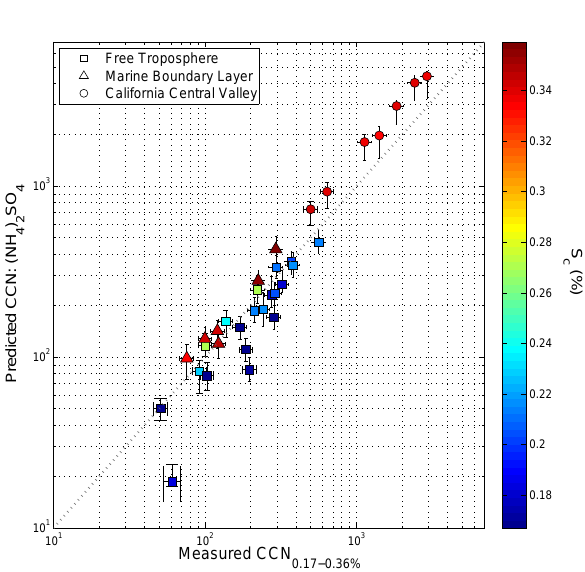
Fig. 4. Predicted CCN vs. measured CCN. Predicted CCN were calculated using pure (NH 4 ) 2 SO 4 composition and the K¨ohler the- ory. Markers are color-coded for the supersatuation at which the CCN measurements were made. Different air mass regions are in- dicated by marker shape and a grey line indicates the 1:1 line. Er- ror bars shown for x-axis represent uncertainty in CCN measure- ments derived from variability during flight leg ( σn − 0 . 5 ) . Error bars shown for y-axis are derived from variability in SMPS mea- surements ( σn − 0 . 5 ) during each level